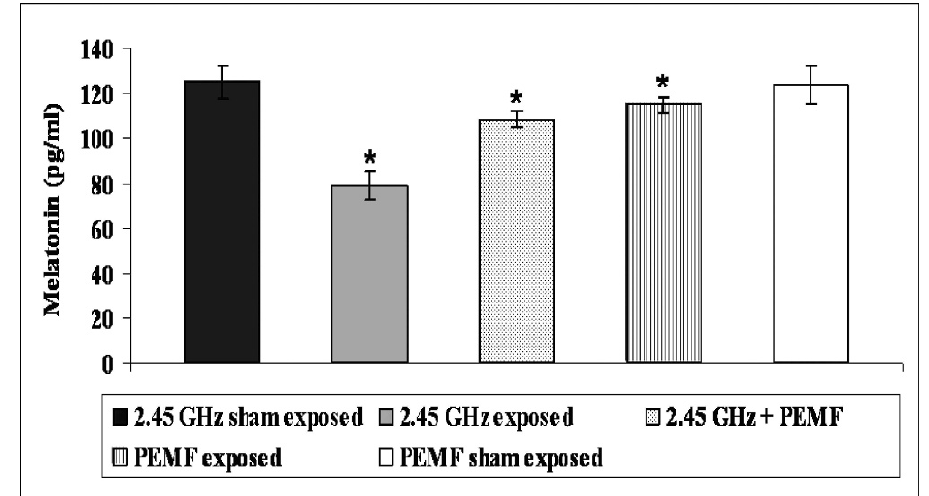
Figure 5 - Melatonin production in the various groups (expressed as pg/ml). A representative experiment is